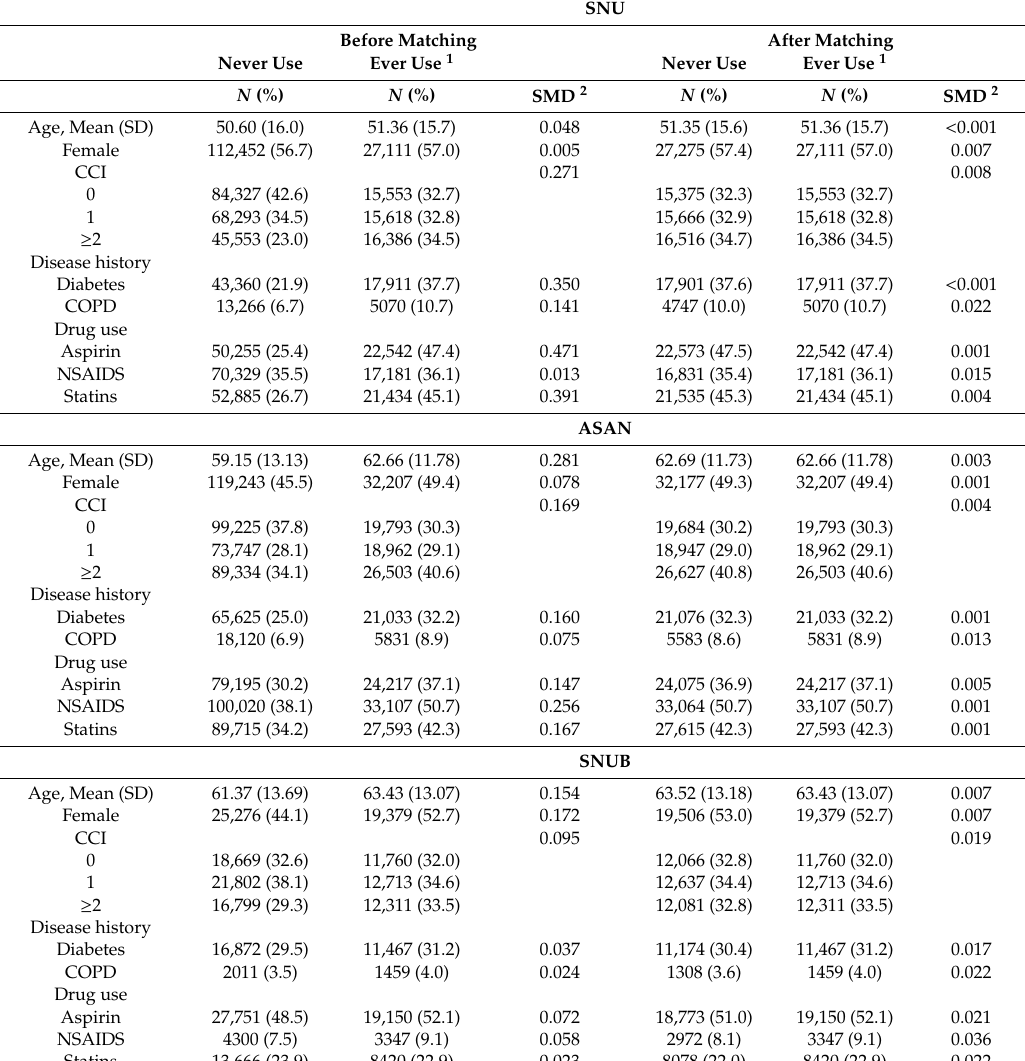
Table 2. Study Participants’ Characteristics before and after Propensity Score